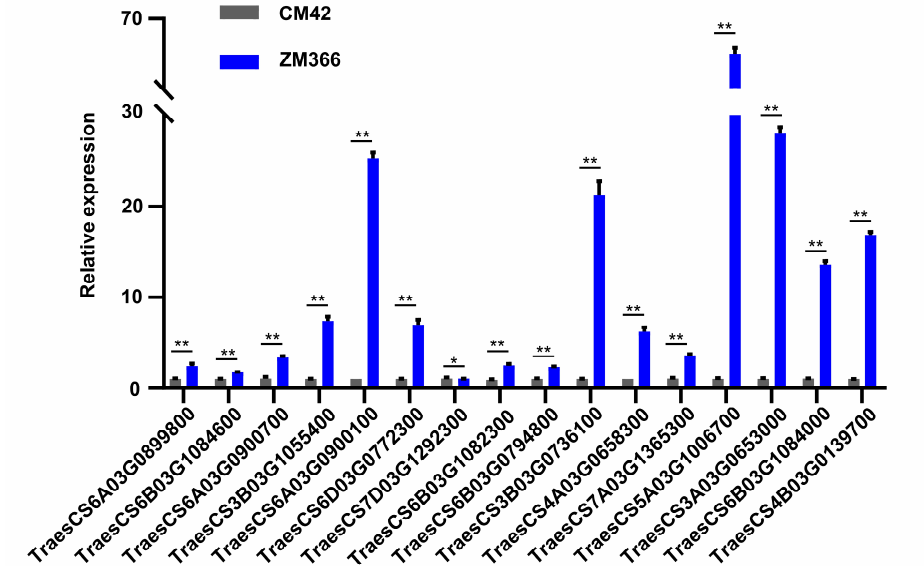
Figure 6. Expression patterns revealed by RT-qPCR. The expression patterns of 16 highly expressed genes in ZM366 compared with CM42 (both treated with 15% PEG-6000) as revealed by RT-qPCR. The experiment was repeated three times, and the error bar represents the SD of the means ( n = 3). ** represents p < 0.01. * represents p < 0.05.